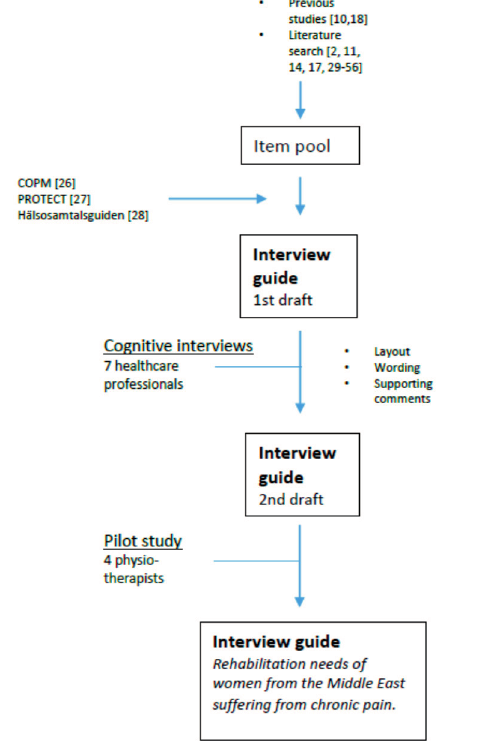
Figure 1. Development of the interview